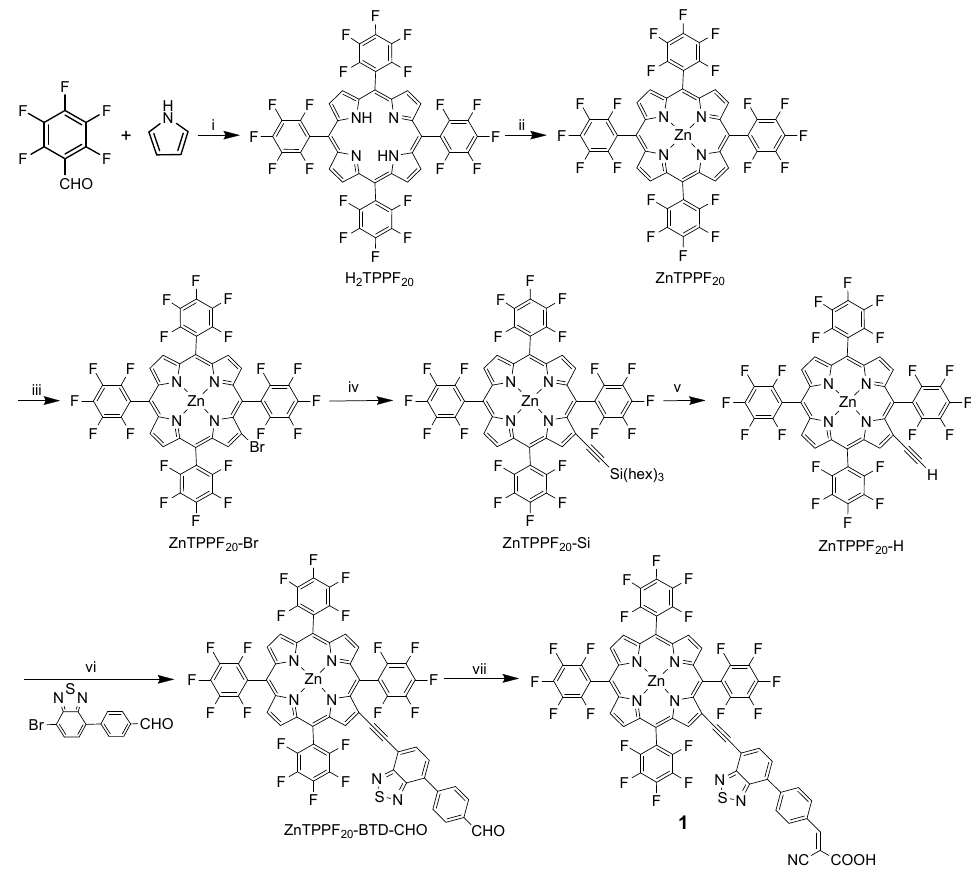
Scheme 1. Synthesis of dye 1.